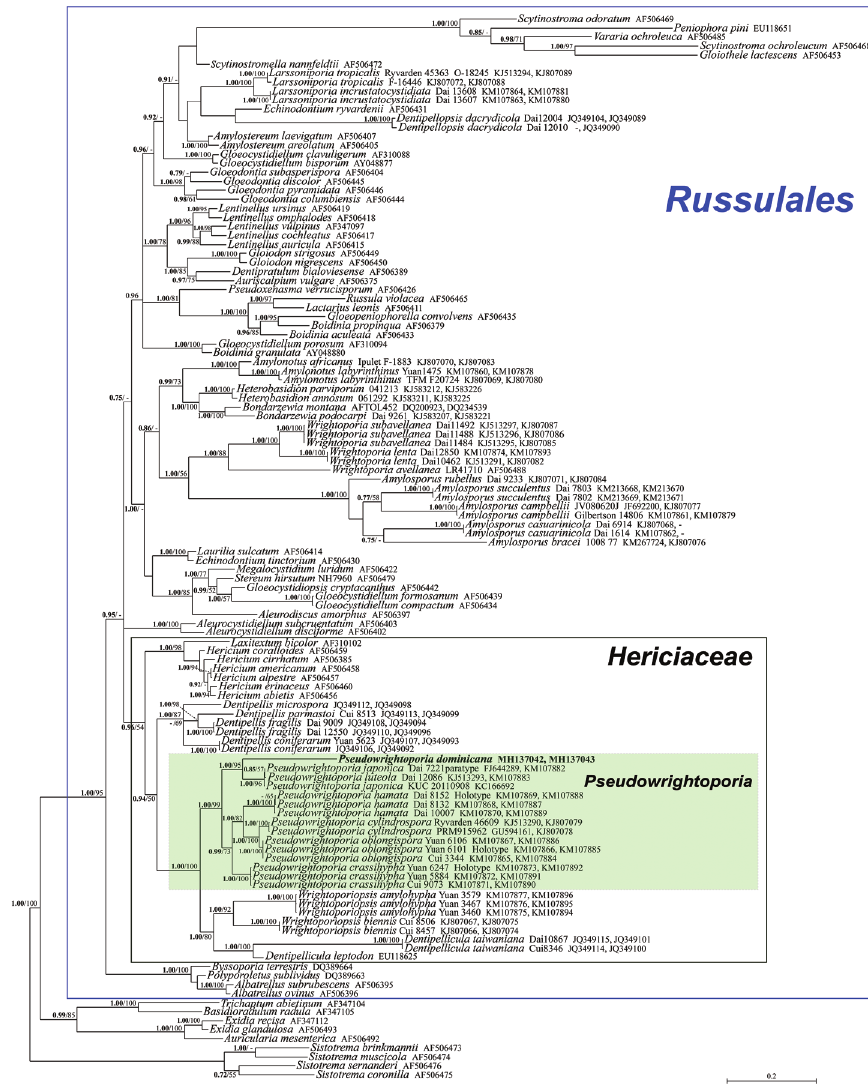
Figure 1. Bayesian phylogram obtained from the combined nrITS-nrLSU sequence alignment of Rus- sulales taxa selected according to Chen et al. (2016). Sistotrema brinkmannii , S. coronilla , S. muscicola and S. sernanderi were used as outgroup taxa. Values for clades that are supported in either the Bayesian (posterior probabilities, BPP) and Maximum likelihood (ML bootstrap percentage, MLB) analyses are indicated. BPP values (in bold) above 0.70 and MLB values above 50% are given above/below branches. The newly sequenced collection is in